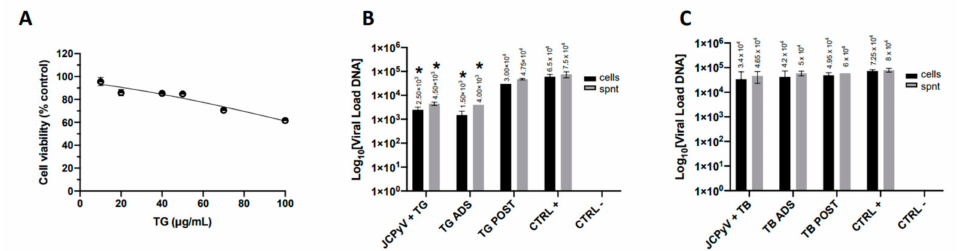
Figure 3. Antiviral properties of TG against JCPyV infection. ( A ) COS7 cells were treated with different TG concentrations to evaluate its cytotoxicity by an MTT assay; ( B , C ) time-of-addition assay: 50 µ g/mL TG ( B ) or 40 µ g/mL TB ( C ) was added to COS7 cells during (ADS) or after (POST) the virus challenge, and viral titers were analyzed in both cell monolayers and conditioned media by Q-PCR 48 h later. Data are mean values ± the SD from two experiments, each performed in triplicate (*, p < 0.05; versus the untreated sample (CTRL+); unpaired t